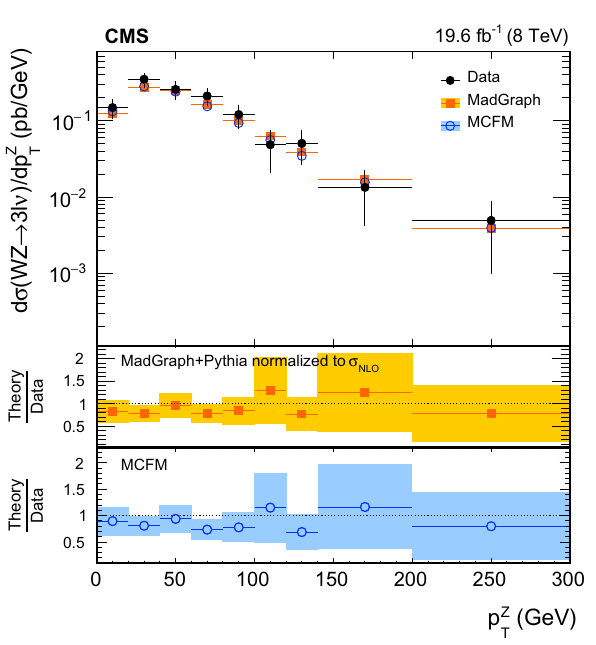
√ Fig. 5 Differential WZ cross section at s = 8TeV as a function of the Z boson transverse momentum. The measurement is compared with mcfm and MadGraph predictions. The MadGraph prediction is rescaled to the total NLO cross section as predicted by mcfm . The error bands in the ratio plots indicate the relative errors on the data in each bin and contain both statistical and systematic